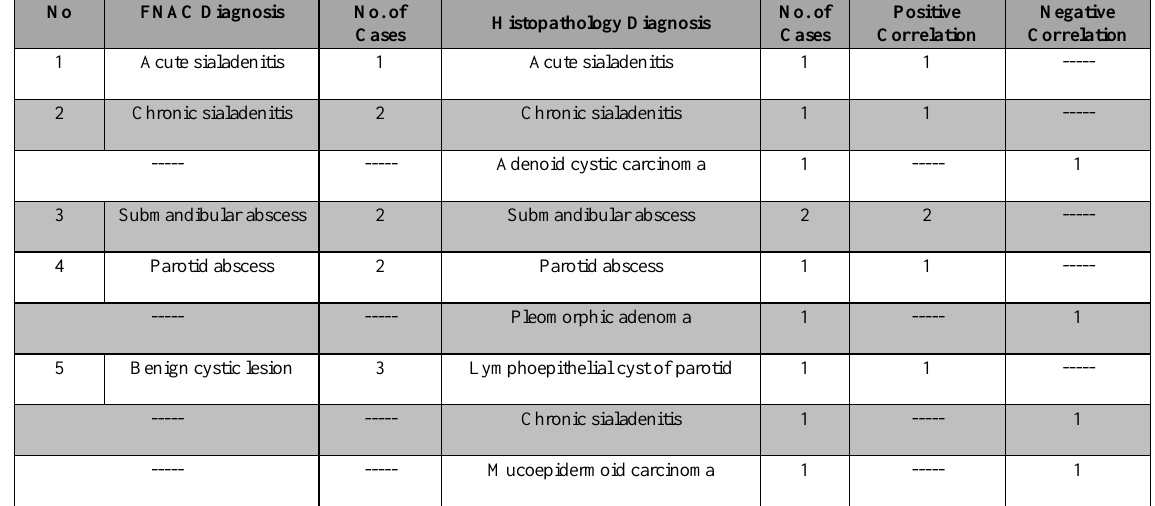
Table 5. Correlation of cytodiagnosis with